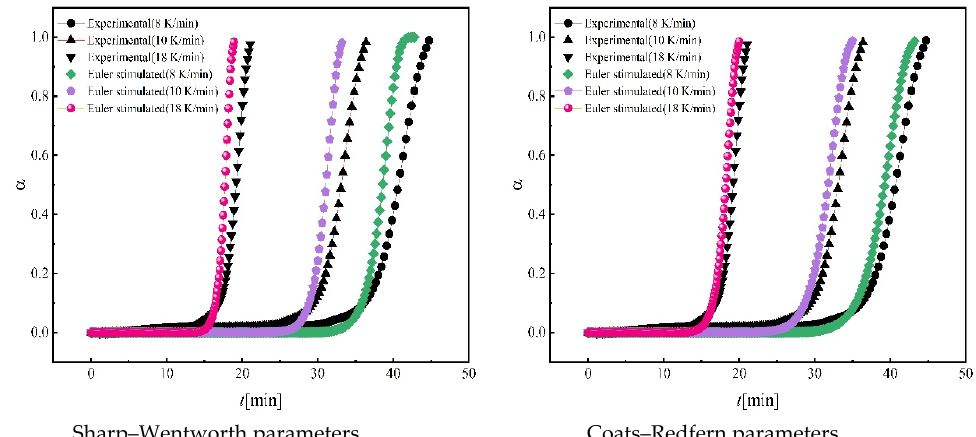
Figure 4. Experimental and predicted data using Sharp–Wentworth and Coats–Redfern parameters of Fe 2 O 3 → Fe 3 O 4 by explicit Euler method.